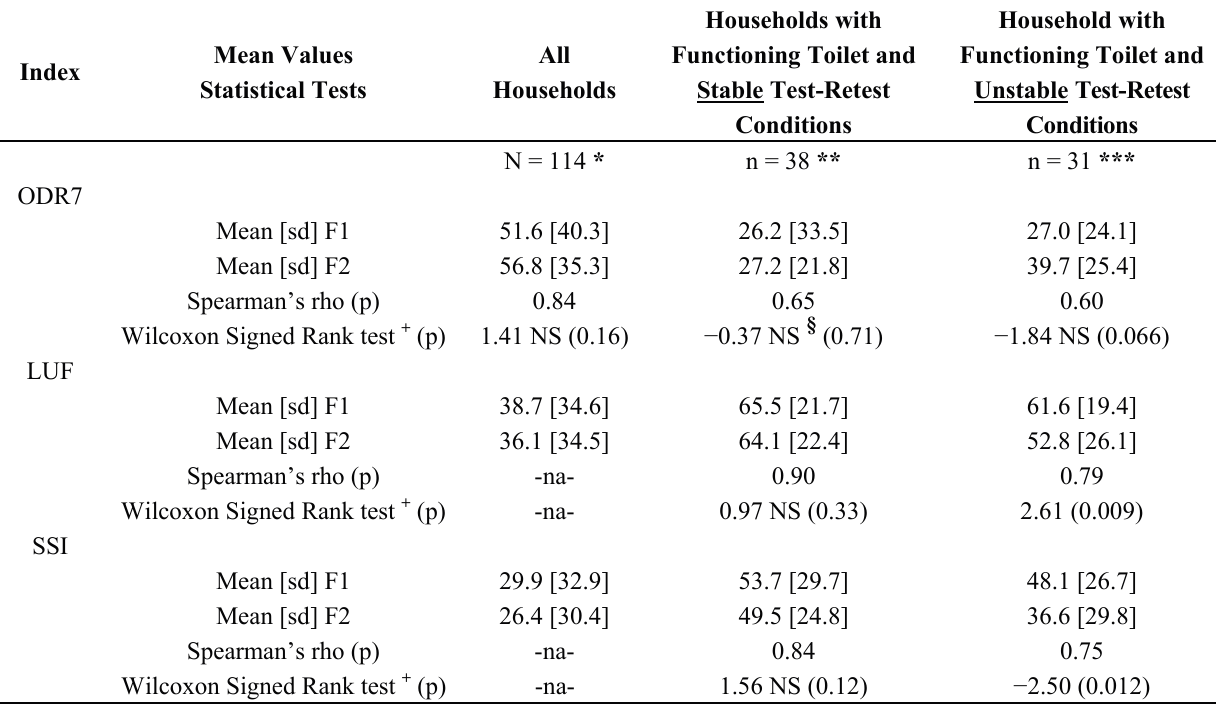
Table 3. Correlation and agreement of scores at the first (F1) and second (F2) follow-up visit.